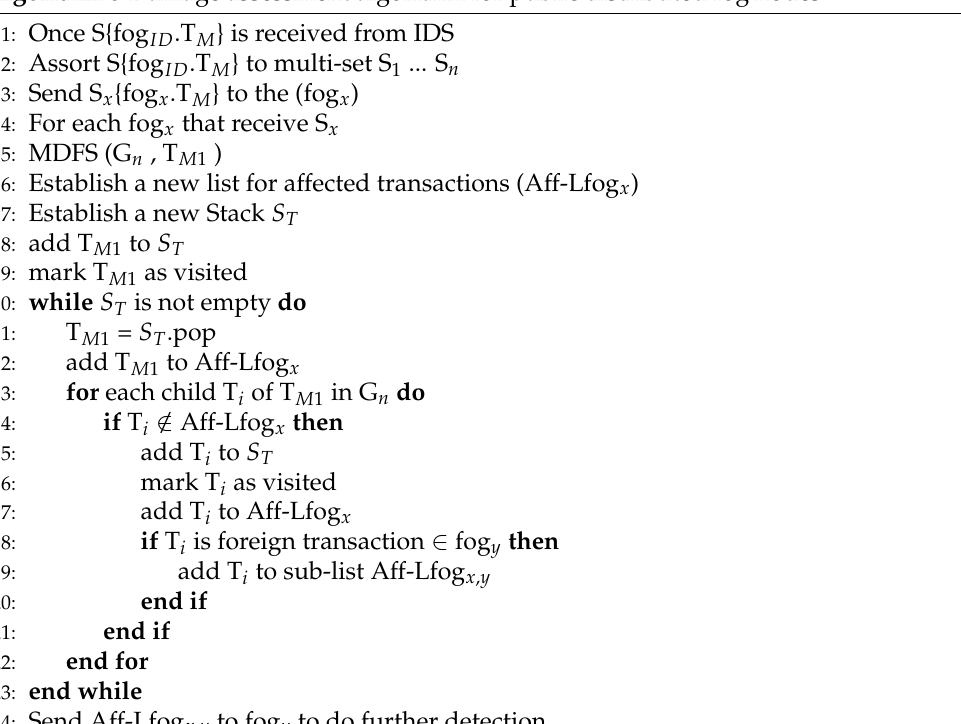
Figure 5. Described local dependency graphs for MSFN 1 and FN pub 2 . • Algorithm 5: damage assessment algorithms for public distributed fog nodes: Algorithm 5 Damage assessment algorithm for public distributed fog